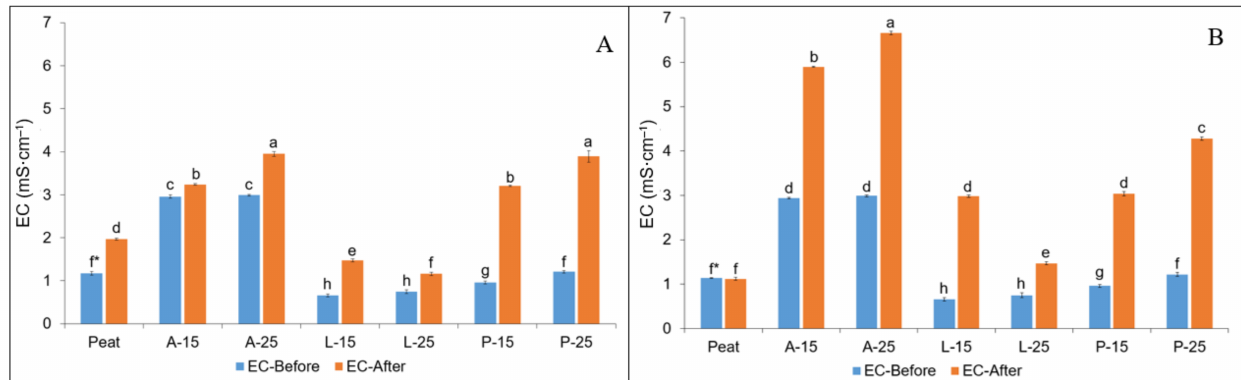
Figure 1. Substrate pH before and after strawberry cultivation in autumn ( A ) and spring ( B ) planting as influenced by substrates, * means followed by the same letters are not significantly different at p < 0.05 according to Tukey’s HSD ( n = 3); the scale on the y-axis ranges from 5.4–6.80.